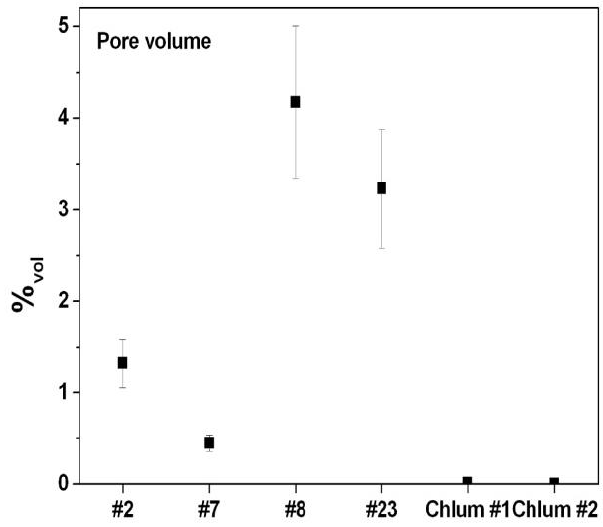
Figure 5. The porosity of the samples is expressed as pore volume percentage. It should be noted that splashform moldavites are characterized by very low porosity (Chlum 1 and Chlum 2 displaying 0.011% and 0.006%, respectively), whereas the Muong Nong-types have much higher values.